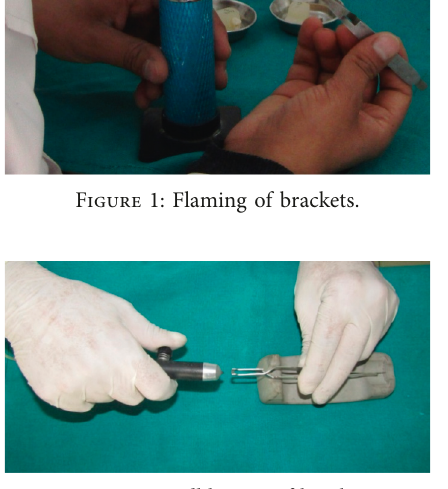
Figure 2: Sandblasting of brackets.